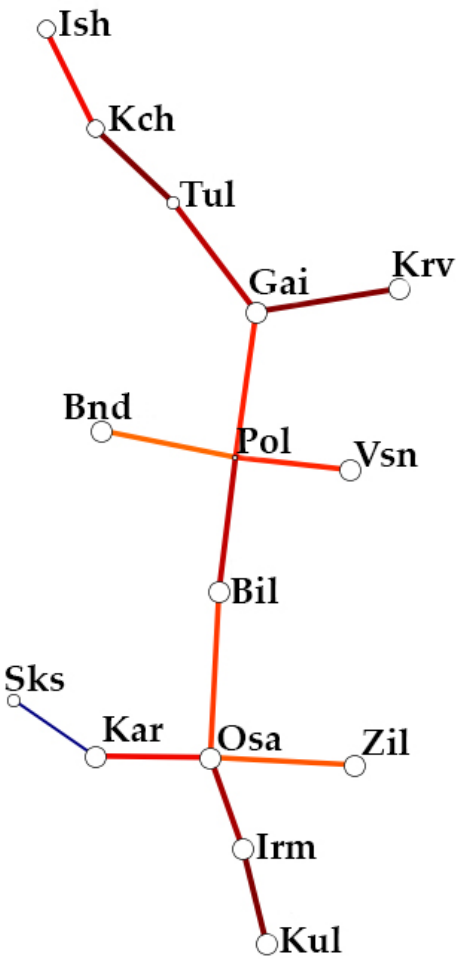
Figure 2. Minimum spanning tree based on Goldstein distances. The rib colors indicate the genetic distance (lighter = shorter distance). The node diameter is proportional to the clonal diversity of the populations.